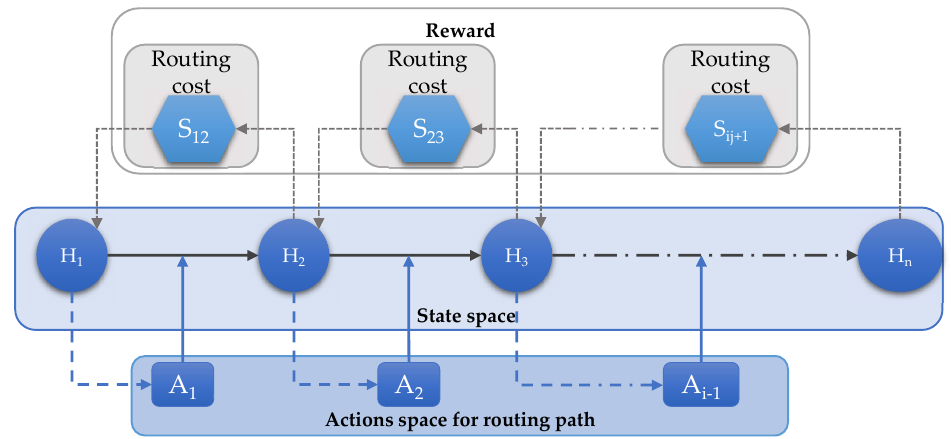
Figure 4. Framework for the stretch reduction strategy in ICN: (1) BSs estimates the state based on received observations over time t, H i ; (2) following the policy the system select the optimal action A i ; (3) and finally system receives reward S ij correspond to the selected